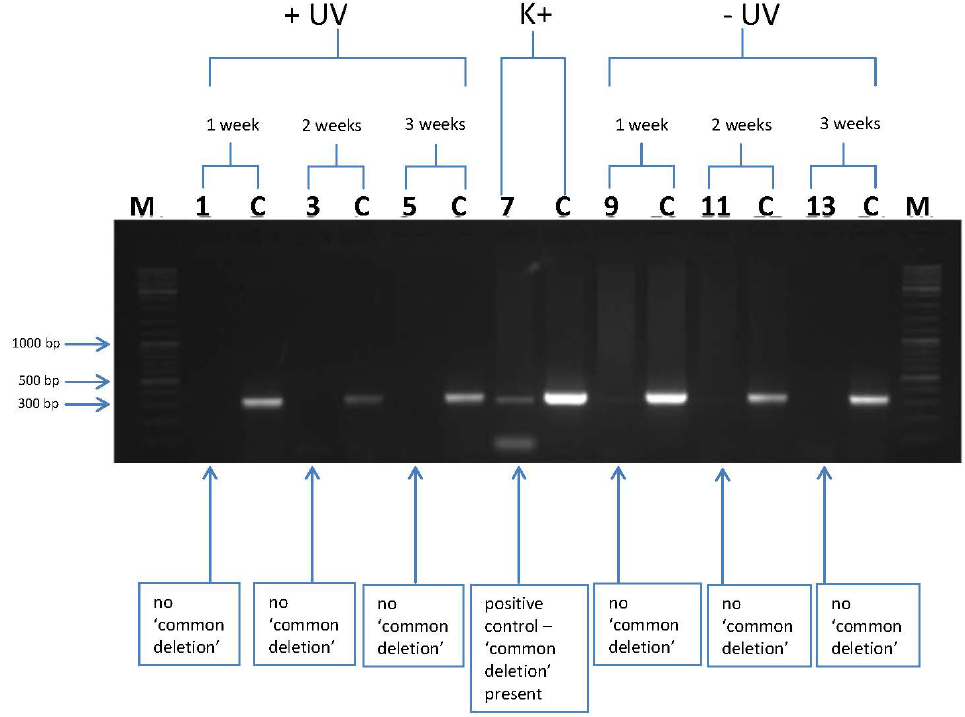
Figure 3. Representative PCR analysis of the presence of the “common deletion” in a culture of human fibroblasts incubated with and without UVA exposure, in the presence of 20 µM L -ergothioneine. M, molecular weight marker; C, control PCR reaction, confirming the presence of mtDNA; 1, fibroblasts after 1 week with UVA exposure; 3, fibroblasts after 2 weeks with UVA exposure; 5, fibroblasts after 3 weeks with UVA exposure; 7, positive control—DNA from a patient with a previously confirmed presence of “common deletion”; 9, fibroblasts after 1 week without UVA exposure; 11, fibroblasts after 2 weeks without UVA exposure; 13, fibroblasts after 3 weeks without UVA